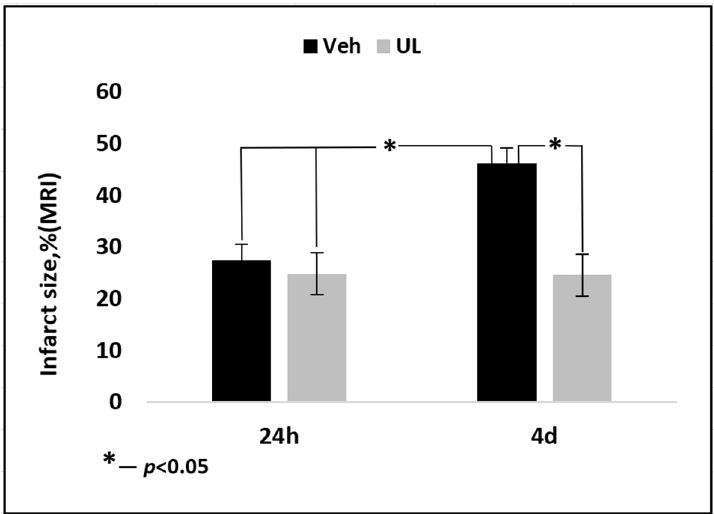
Figure 4. Brain infarct size (% to ipsilatheral hemisphere) 24 h and 4 days after middle cerebral artery occlusion. Groups: Veh–MCAO+Vehicle; UL–MCAO+Ubiquinol.